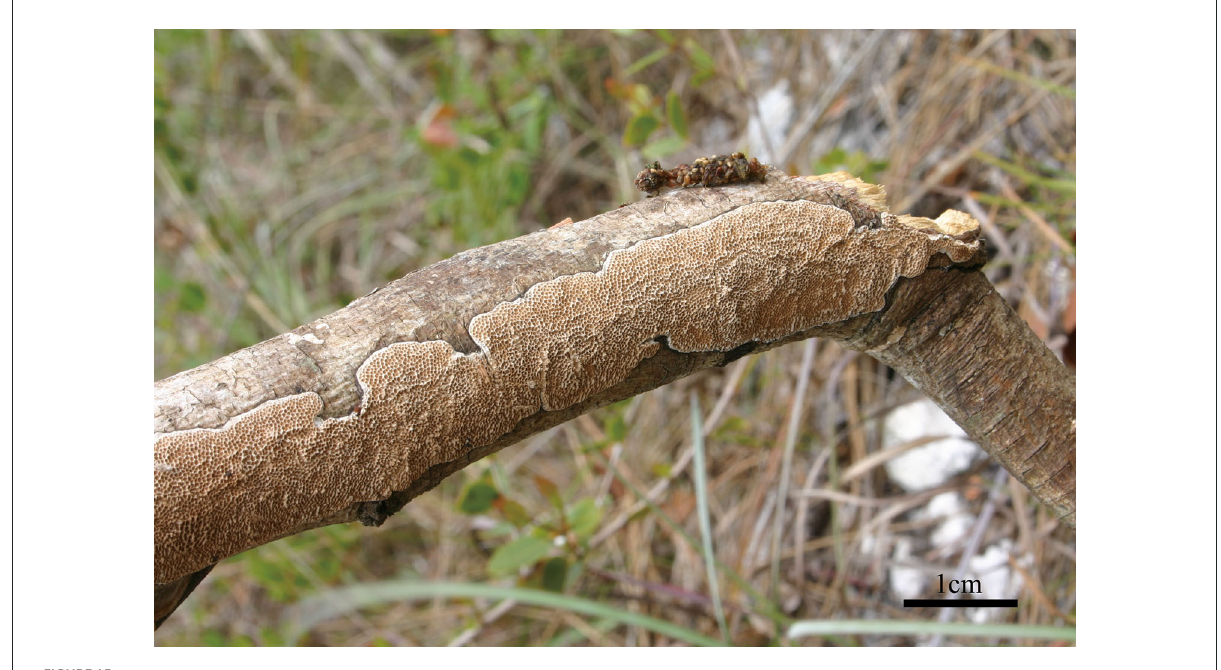
FIGURE15 A basidiocarp of Megasporia sp. 1 (JV 0904/50-J).